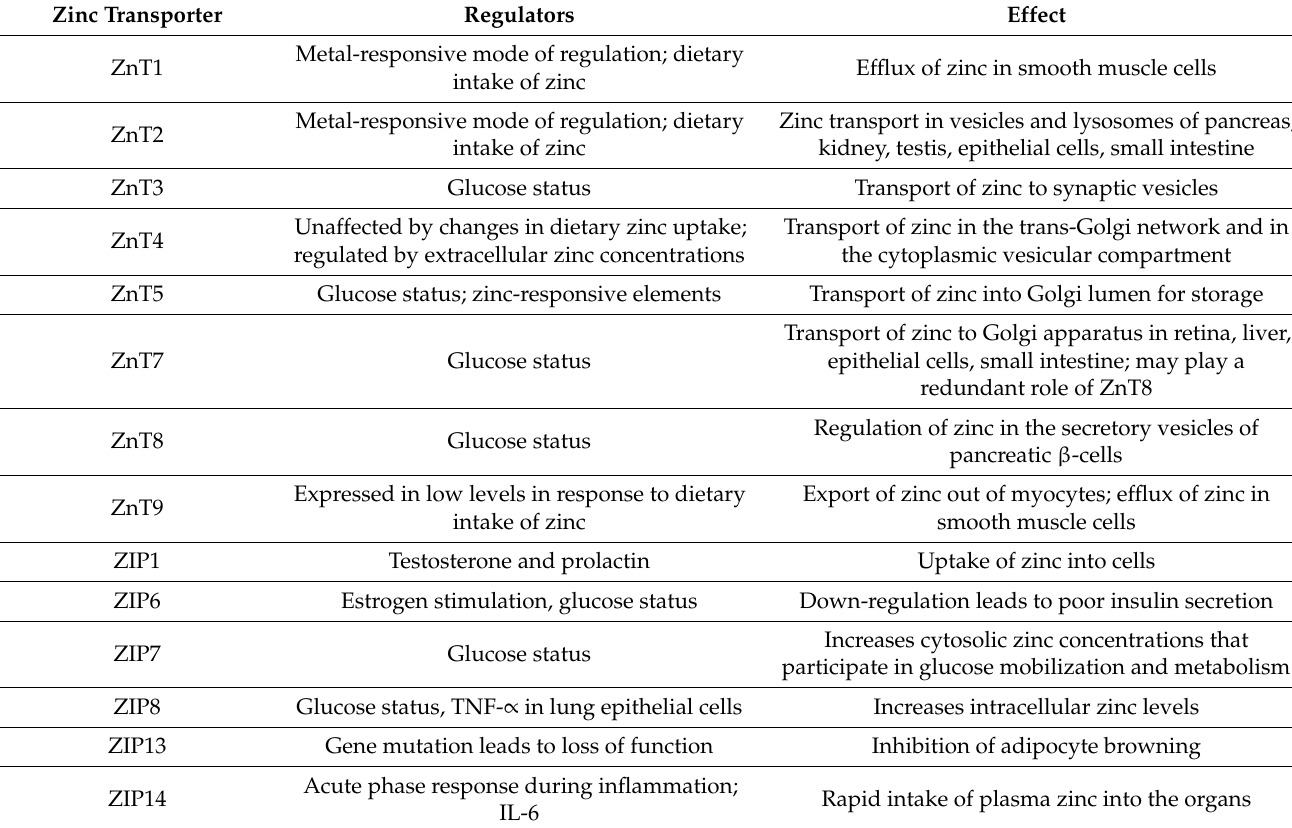
Table 1. Zinc transporters, regulators, and effect his is a